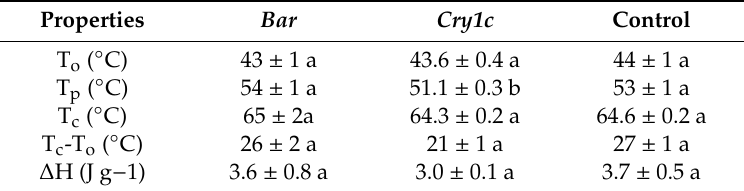
Table 1. Thermal properties of retrograded starches of transgenic lines and control lines from DSC. Mean ± SD is calculated from duplicate measurements. Di ff erent letters within a row indicate significant di ff erences ( p < 0.05).